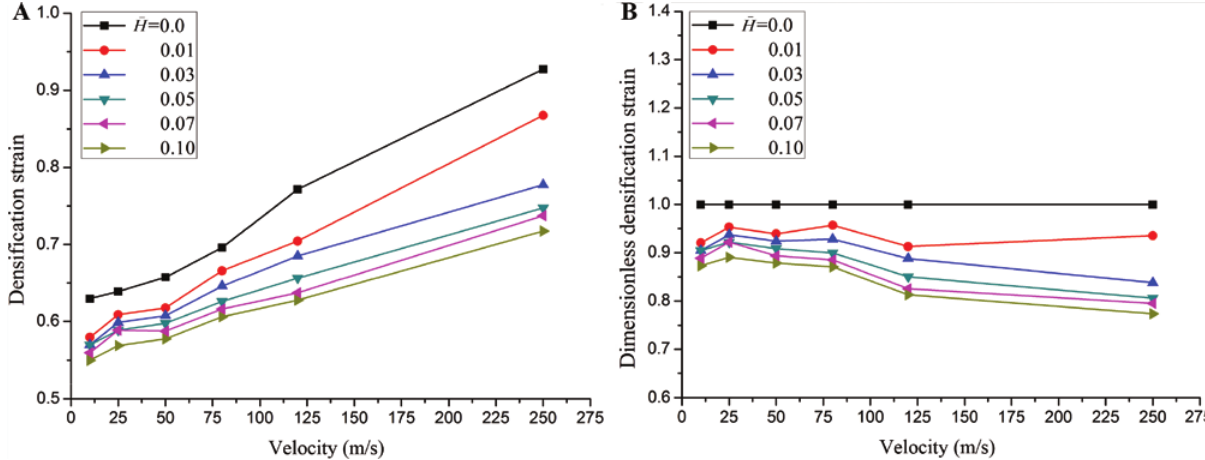
Figure 9: Densification strain (A) and the dimensionless one (B) at the impact side.